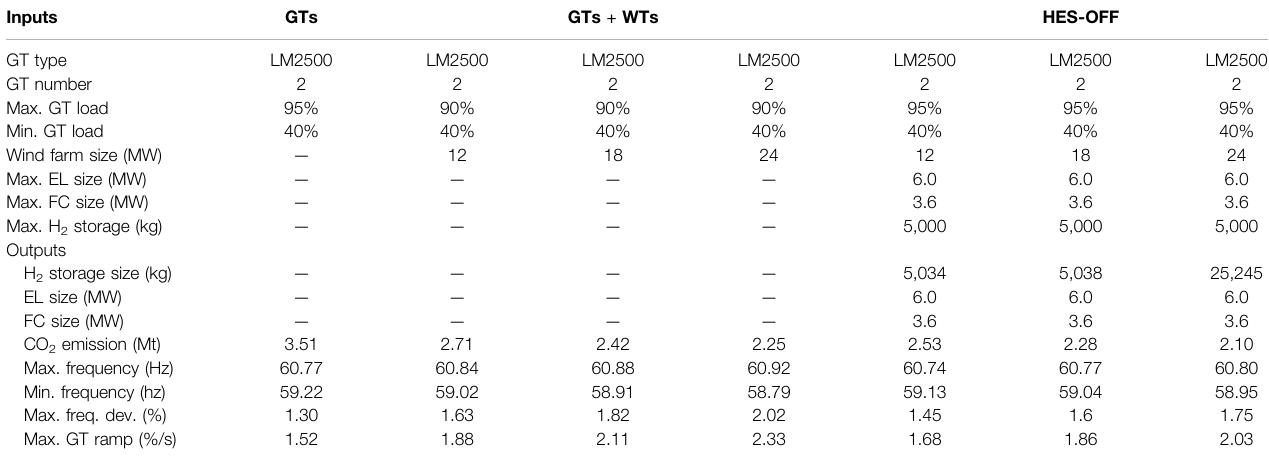
TABLE 2 | Designs based on the LM2500 GT - Comparative analysis between a standard concept on GTs only (GTs), a concept involving GTs and WTs (GTs + WTs), and the proposed concept (HES-OFF). Inputs